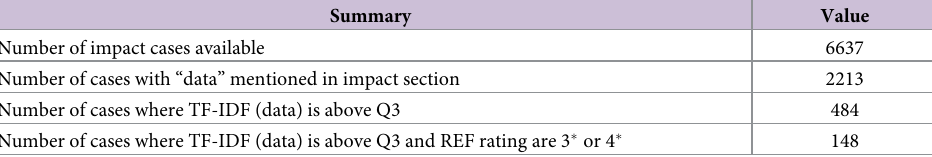
Table 1. Different stages of information retrieval to identify candidate